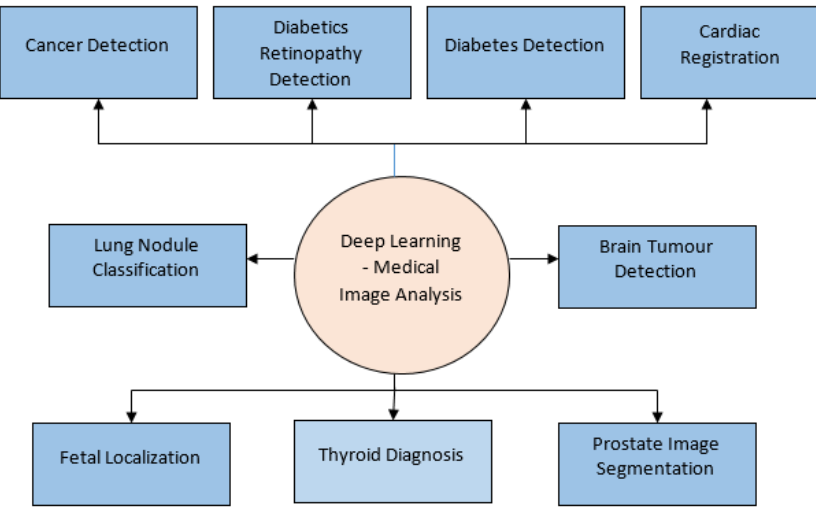
Figure 3. Deep learning applications in medical image